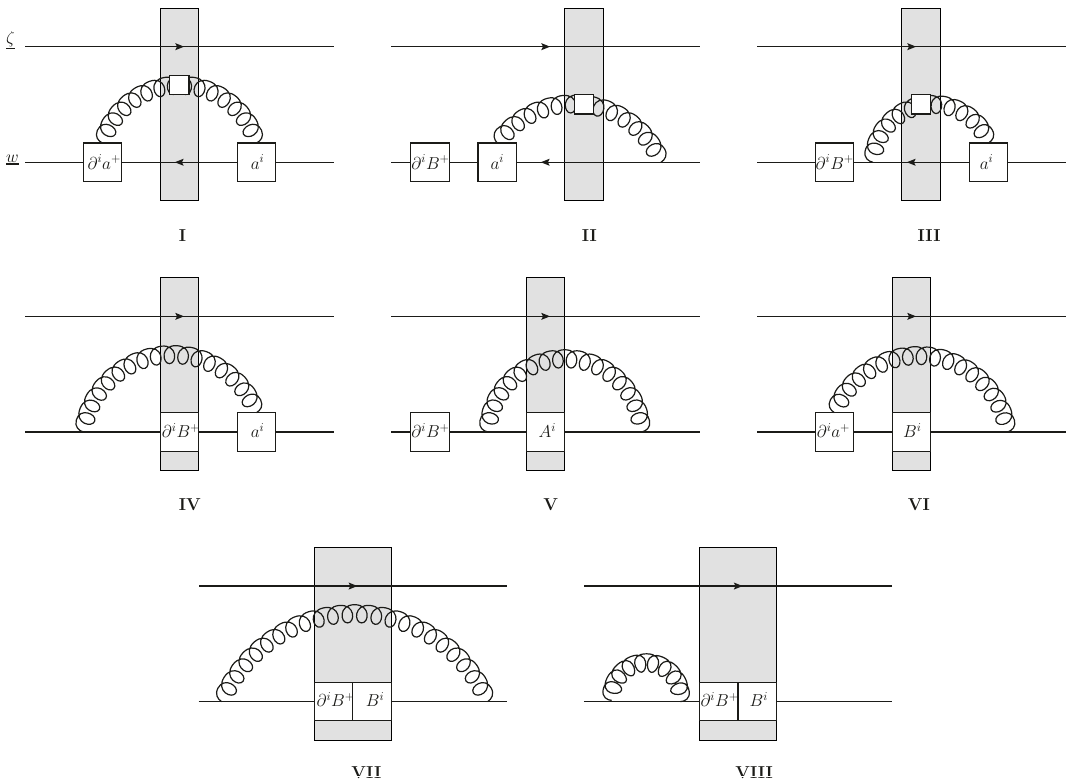
Figure 9. Diagrams illustrating the main types of contractions in the small- x evolution of the polarized dipole amplitude F [2] from (3.38b). Solid straight lines represent the fundamental Wilson w,ζ lines, the boxes with a i , ∂ i a + , B i , and ∂ i B + represent the operator insertions in eq. (3.50), while the box on the gluon line in the shock wave represents an insertion of the entire operator from eq.